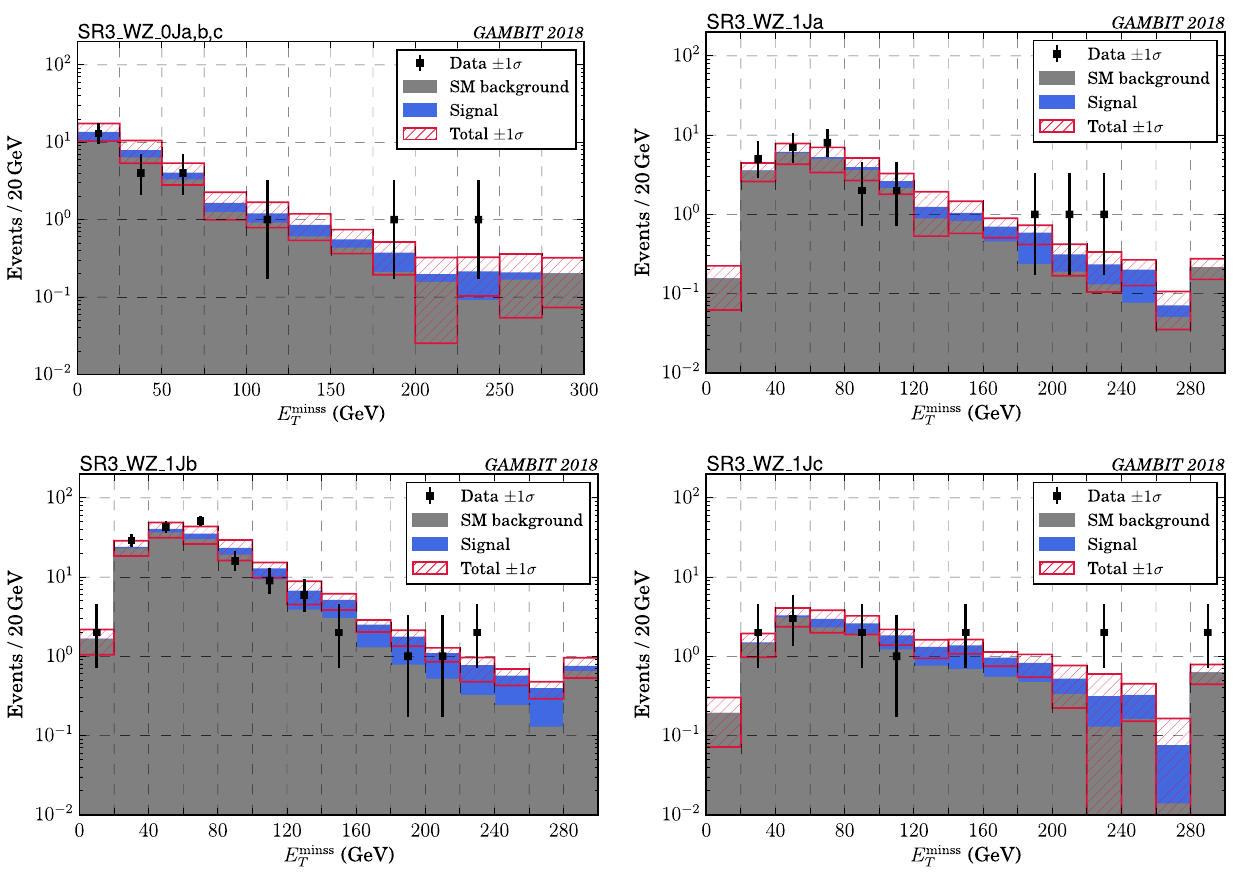
Fig. 21 Distribution of missing transverse energy in the 3 lepton sig- nal regions of the traditional ATLAS multilepton analysis, after apply- ing all selection requirements. The grey bars show the total SM back- ground(takenfromRef.[116])andthestackedbluebarsshowthesignal for our best-fit point based on the combination of 8 and 13TeV data.